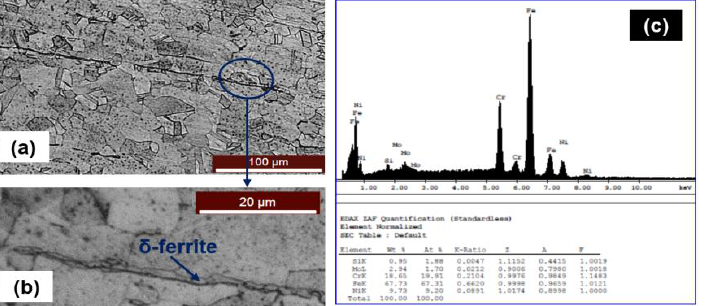
Figure 21: Cross-sectional etched optical micrograph.